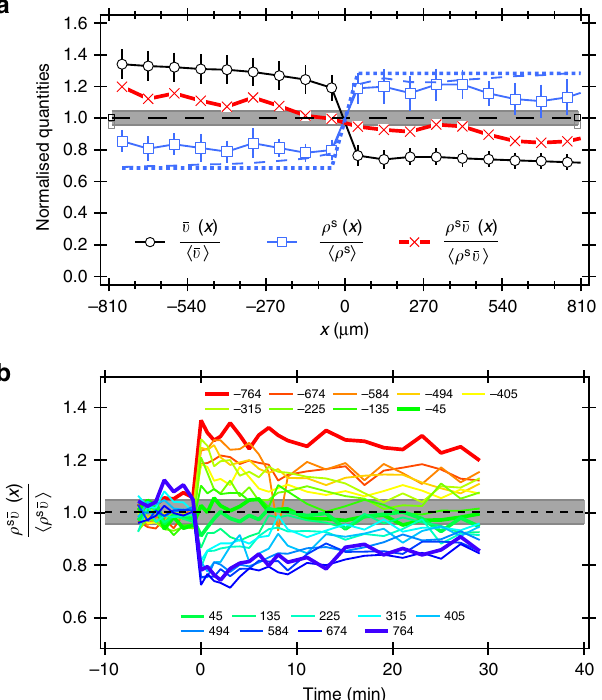
Fig. 3 Response of AD10 at OD = 1 to a stepped intensity pattern. The same quantities as in Fig. 2 are shown. Qualitatively the behaviour is the same as for the higher density, but the data are noisier due to the overall weaker signal. See Supplementary Figs. 4 and 5 for spatial maps and time